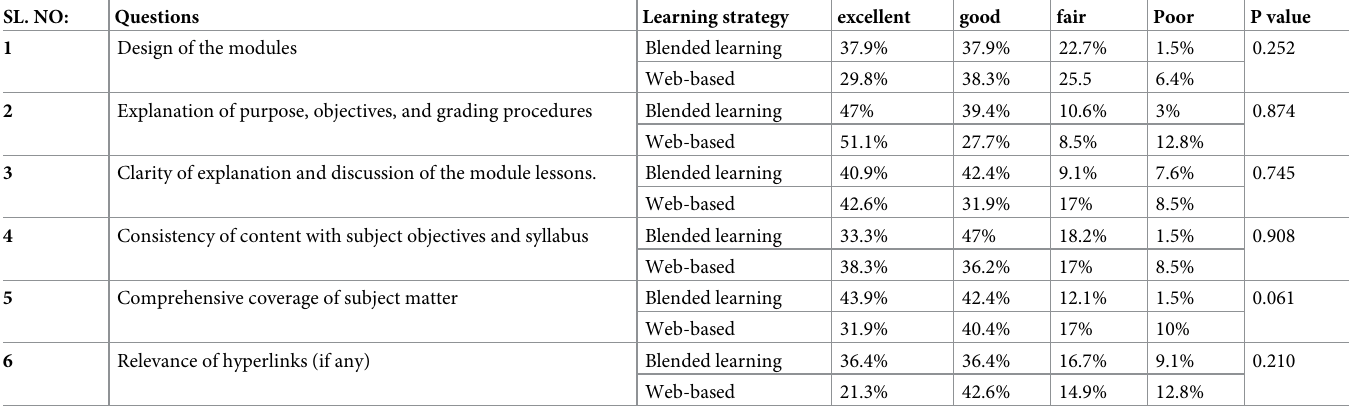
Table 5. Students’ attitude towards web -based e-learning